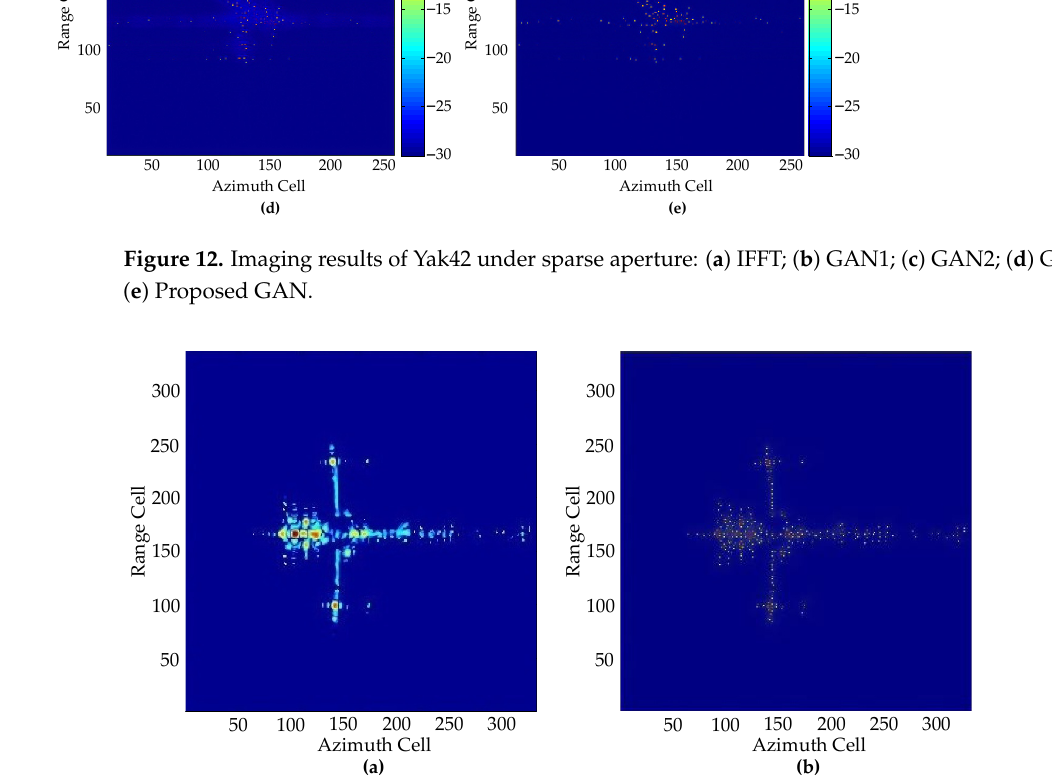
Figure 13. Imaging results of F-16: ( a ) Original image in the microwave chamber; ( b ) Proposed GAN.